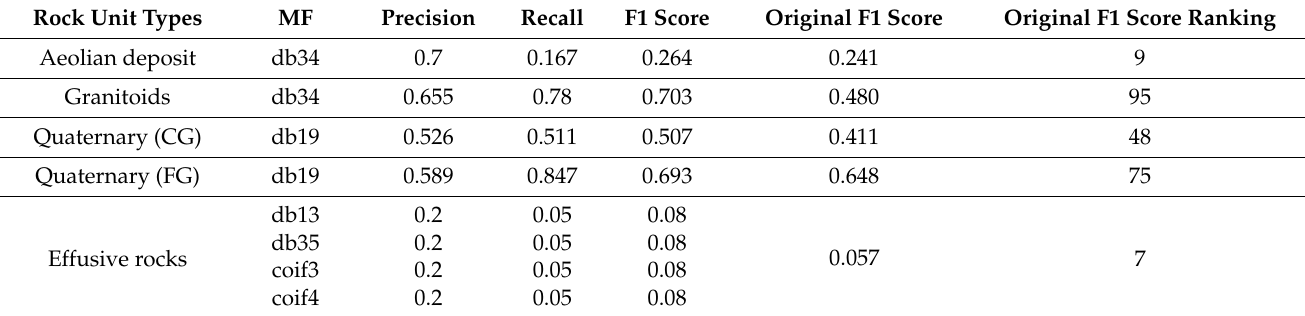
Table 6. The highest value of F1 score among the rock units on Sentinel-1 data using